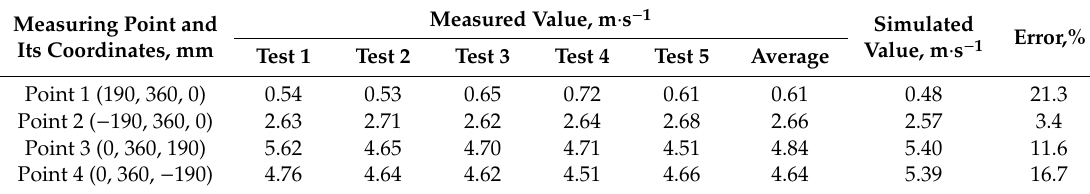
Table 1. X-axis wind speeds at each measuring point of the tank.